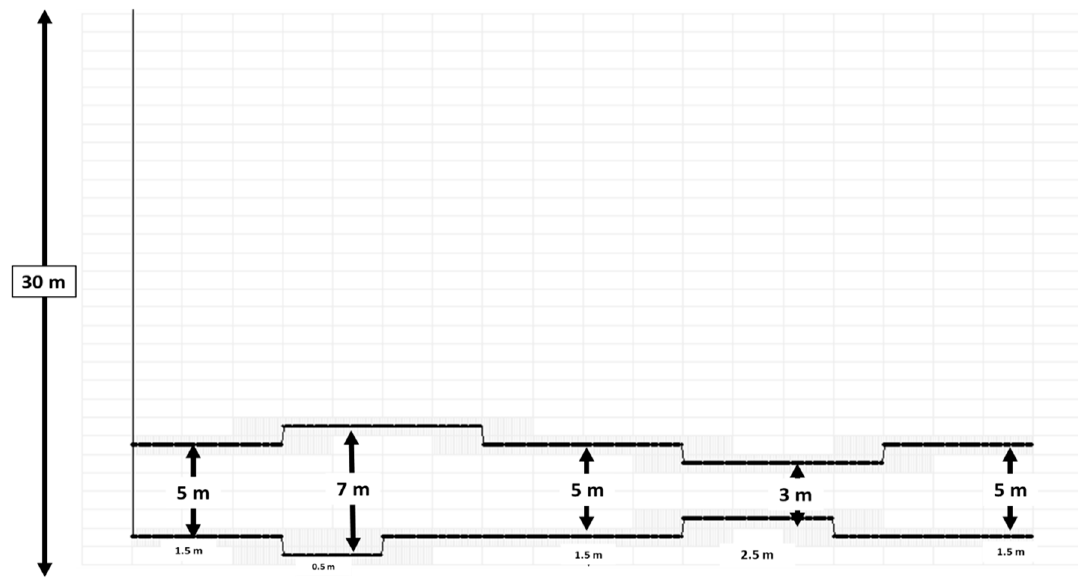
Figure 2. Well completion scheme for the base case.